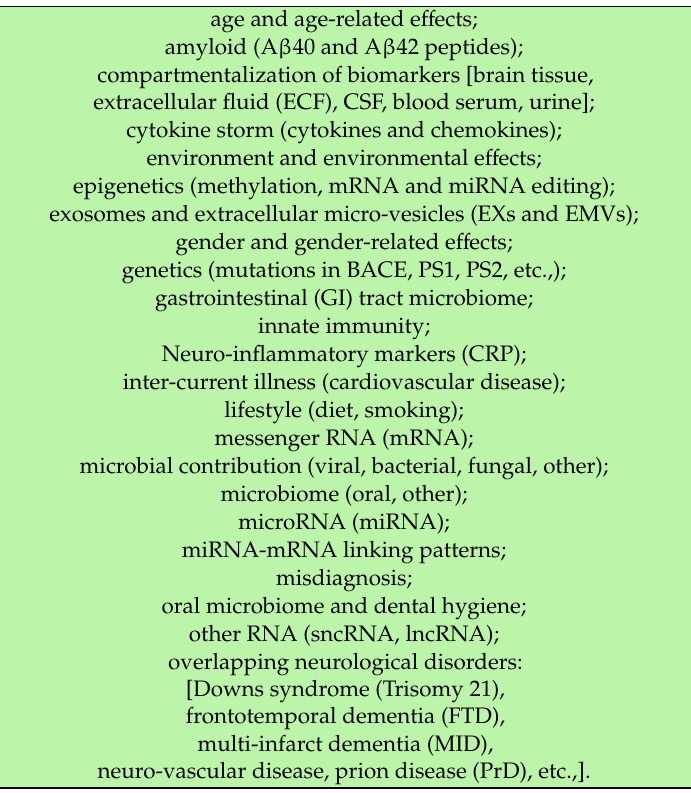
Table 1. Multiple interrelated factors contribute to AD. The considerable heterogeneity of Alzheimer’s disease (AD) appears to be mediated in part by a highly interconnected network of biological factors, and each of these can be used as diagnostic biomarkers which appear to each have a variable potential to contribute to AD-type change. There is abundant evidence that all 23 of these biomarkers and / or factors (listed alphabetically) contribute to AD initiation, onset, or propagation, and there may be other important biological factors and other elements that may contribute to this complex neurological disease that we have not yet recognized or even considered. Data derived from each of these multiple biomarkers and factors combined is amenable to systems and network analysis, information integration, and the application of precision medicine that should ultimately yield a more accurate diagnosis of AD at any stage of the disease (see text for references; specific references to the biomarkers listed in Table 1 can be found in [15–29]. Abbreviations: BACE = β -amyloid cleavage enzyme; CRP = C-reactive protein (a blood-serum-based inflammatory biomarker); lncRNA = long non-coding RNA; PSI, PS2 = presenilin 1, presenilin 2; rRNA = ribosomal RNA; sncRNA = sall non-coding RNA. age and age-related e ff ects; amyloid (A β 40 and A β 42 peptides); compartmentalization of biomarkers [brain tissue, extracellular fluid (ECF), CSF, blood serum, urine]; cytokine storm (cytokines and chemokines); environment and environmental e ff